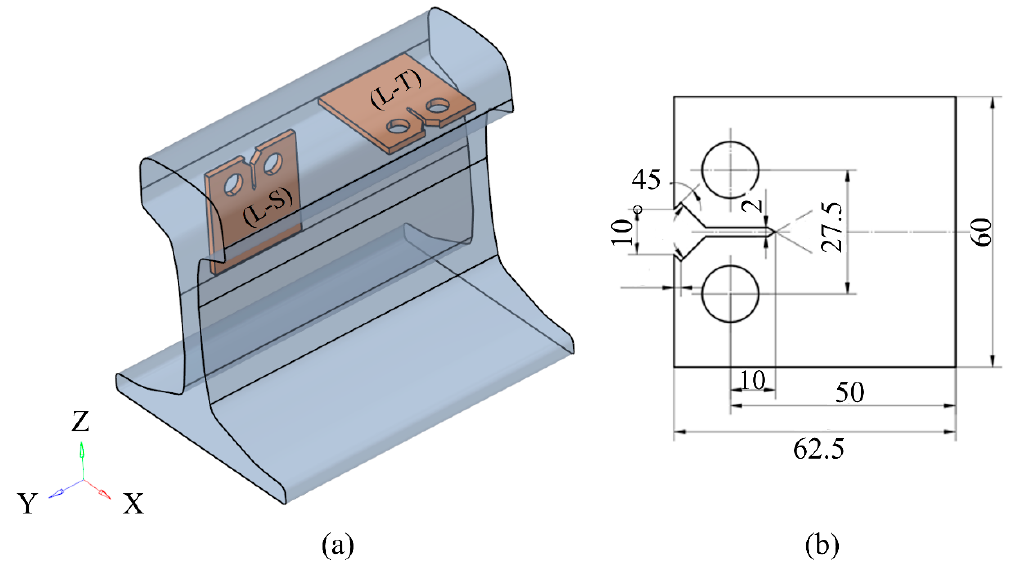
Figure 5. Specimen sampling positions and its dimensions, unit: mm.